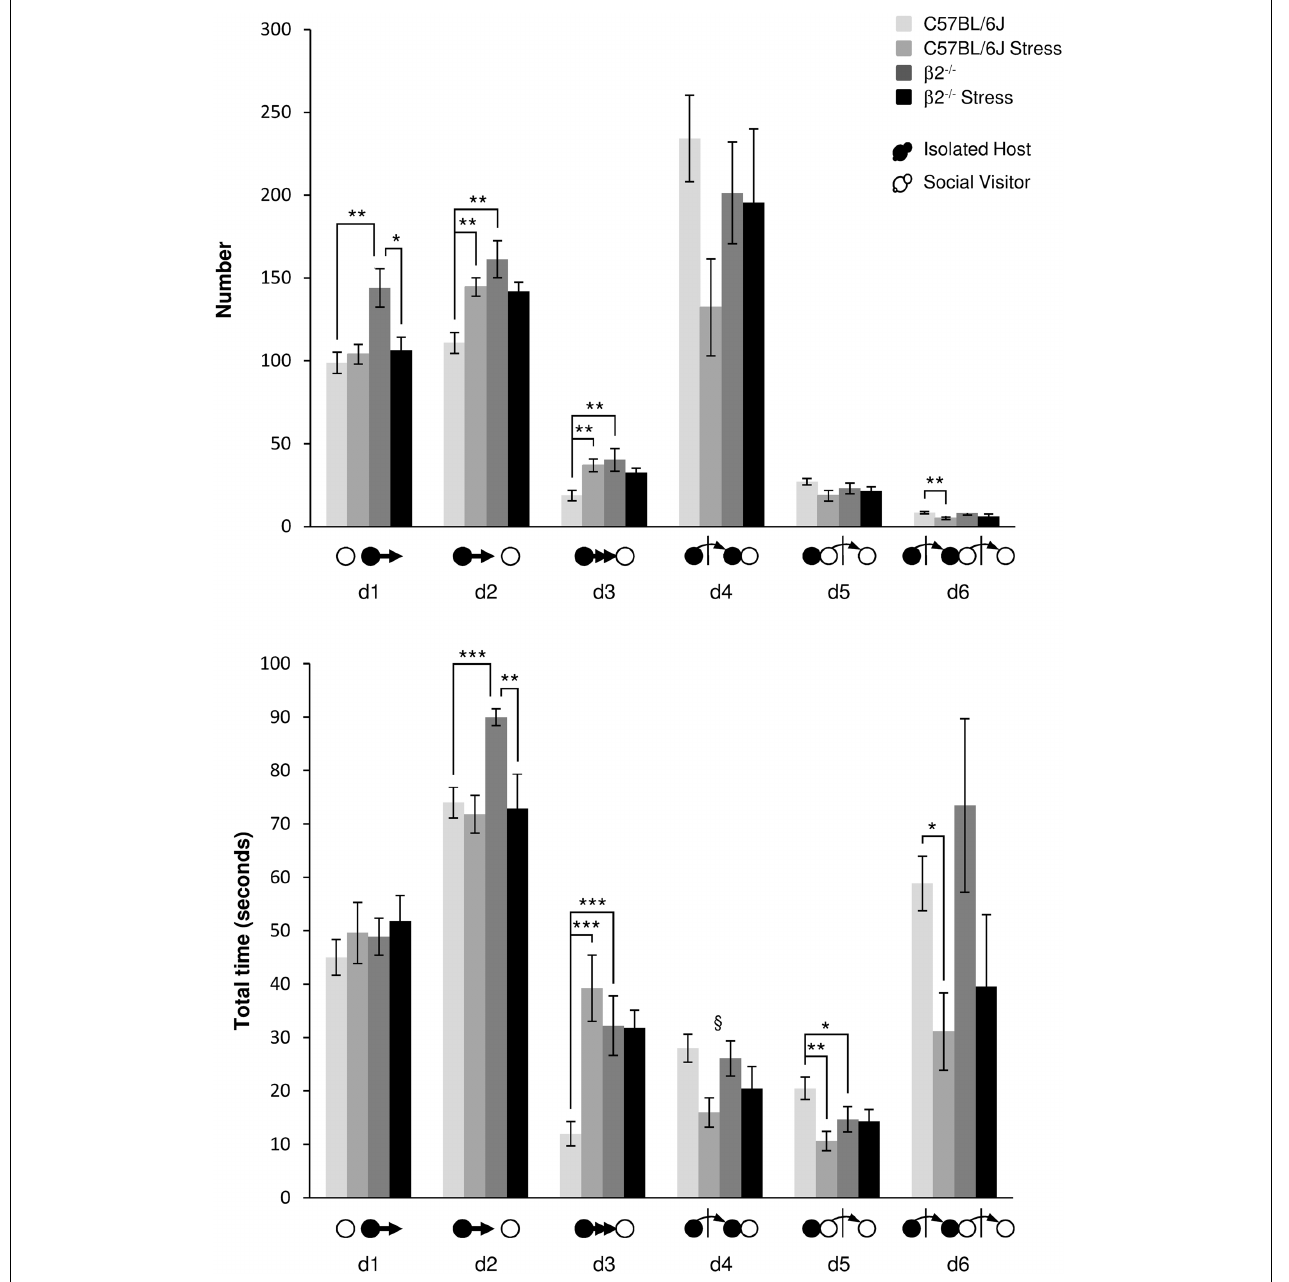
FIGURE 4 | Dynamic events during social interaction: events initiated by the Isolated Host mouse. The number ( Top ) and the total time ( Bottom ) of the dynamic events (d1 to d6 as referred in Table 1 and Supplementary Table 1) were quantified during the 4min of the social